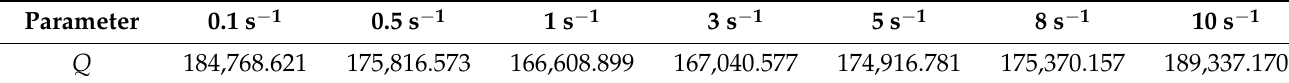
Table 4. The values of Q under different deformation rates.